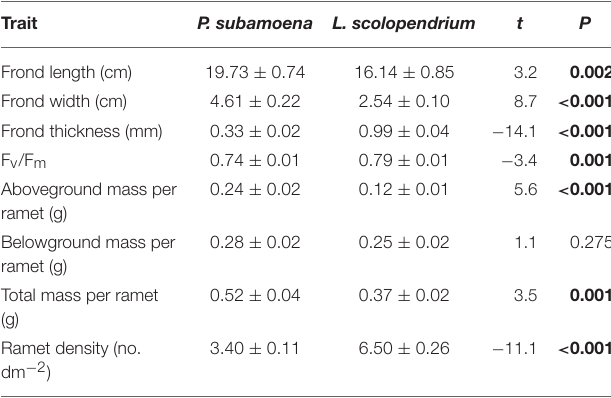
TABLE 1 | Contrasting functional traits of the ramets of two species, Polypodiodes subamoena and Lepisorus scolopendrium.